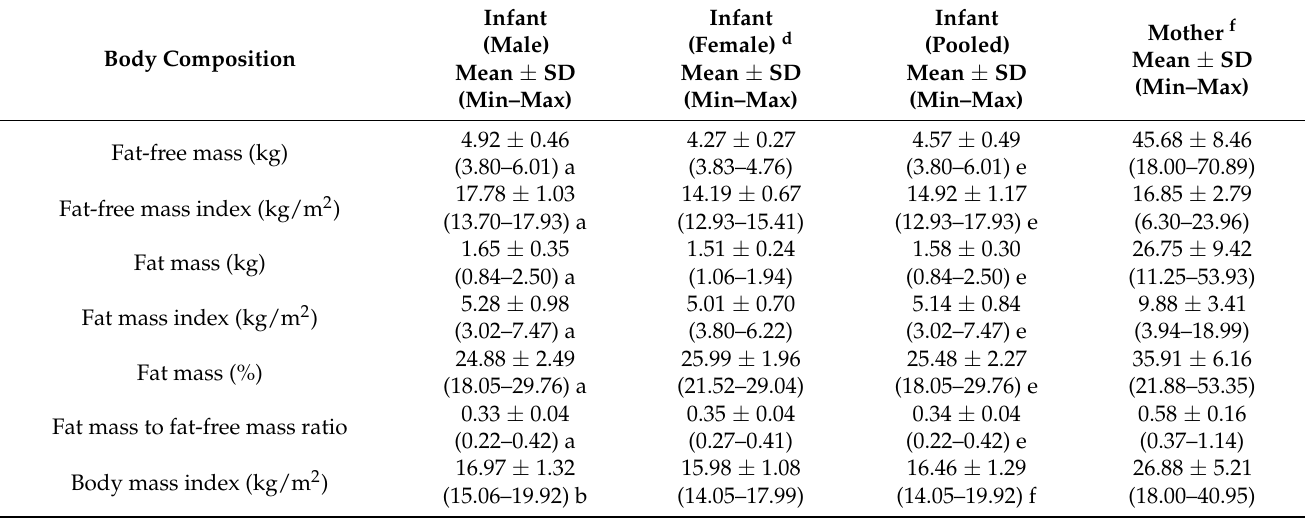
Table A1. Maternal and infant body composition at 3 months